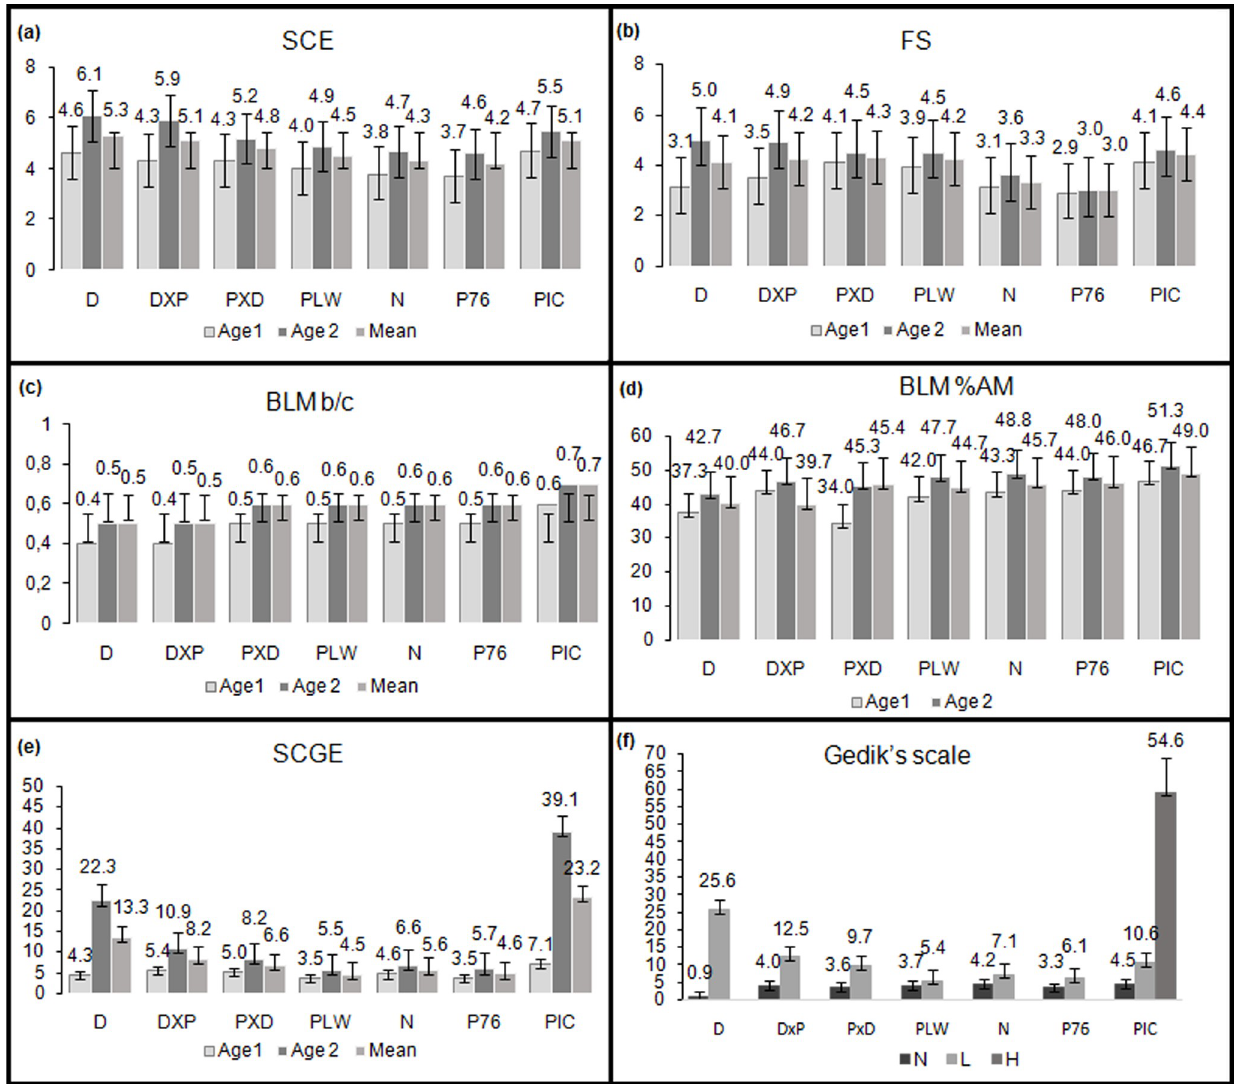
Fig 2. Number of instabilities identified in each breed of boar depending on age: a) SCE, b) FS, c) BLM b/c, d) BLM %AM, e) SCGE, f) DNA damage according to Gedik’s scale. (A) abcde mean values with different superscript letters are statistically different (P < 0.05) between breeds. (B) ab mean values with different superscript letters are statistically different (P < 0.05) between age groups 1 and 2.